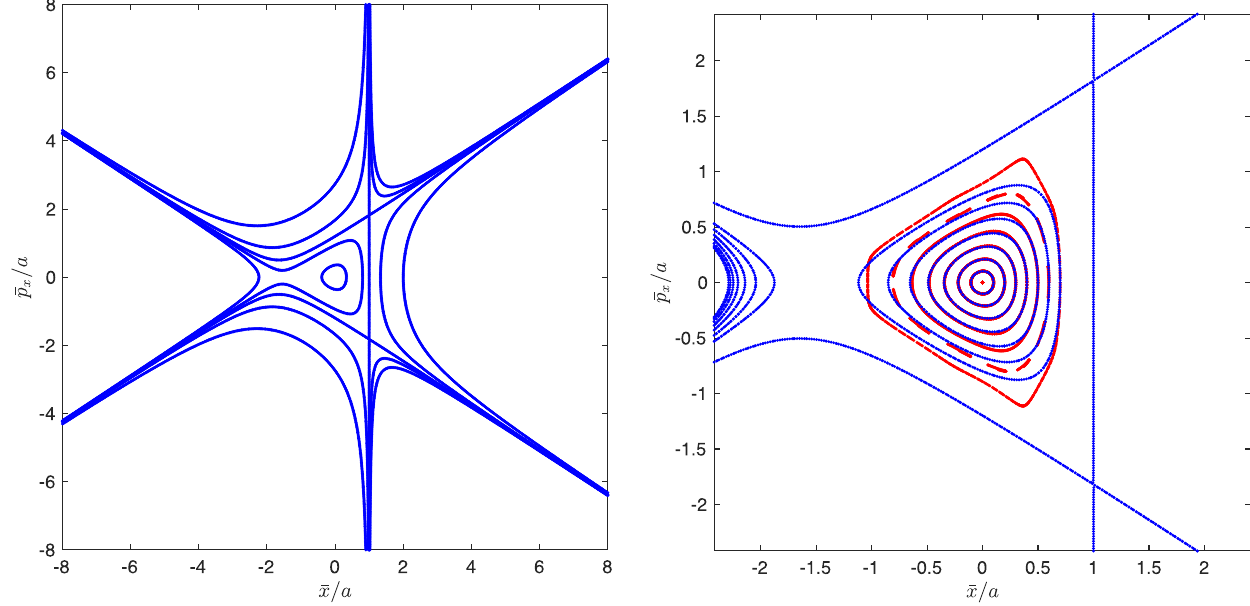
FIG. 8. Open geometry in the phase space for the effective Hamiltonian in Eq. (37) on the left and comparison to tracking on the right with betatron tune ν ¼ 0 . 396 .